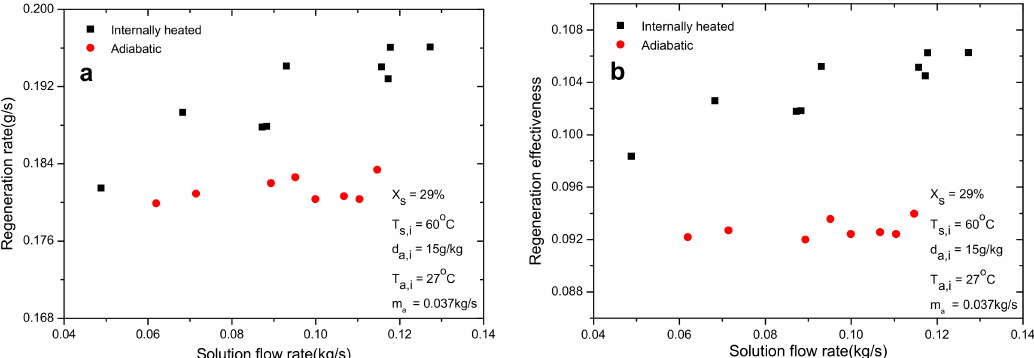
Figure 10. Effect of solution flow rate on regeneration performance: ( a ) regeneration rate; ( b ) regeneration